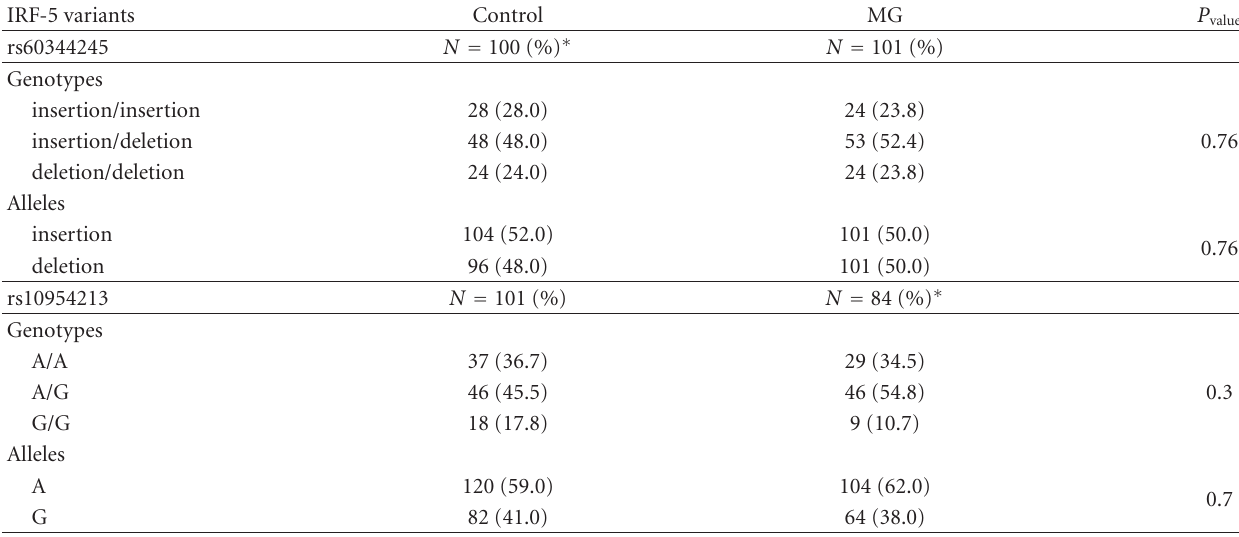
Table 2: Genotype and allele distribution of IRF-5 variants in MG patients and controls. Statistical values calculated by χ 2 test are also shown.